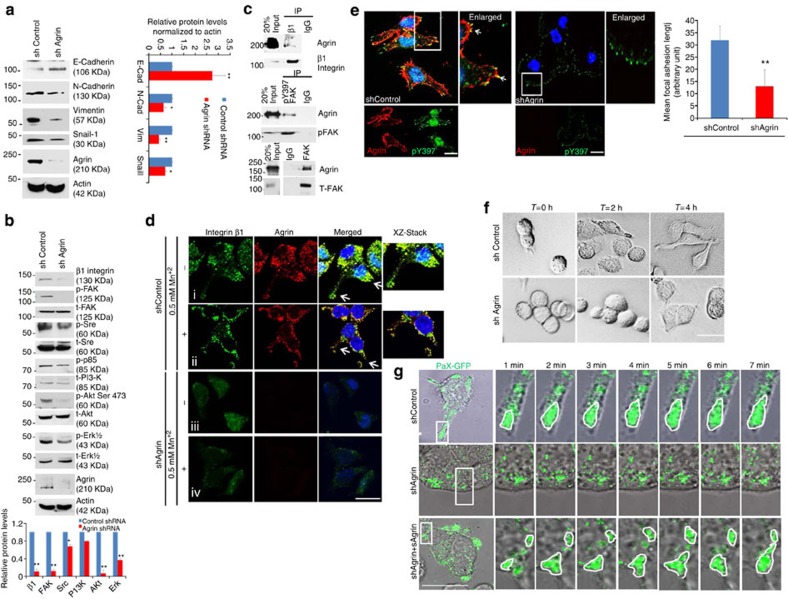
Agrin as an ECM sensor for EMT and FA integrity.(a,b) Total lysates of control or Agrin shRNA MHCC-LM3-transduced cells were analysed by western blots using antibodies against the indicated proteins. Quantification of proteins normalized to actin (a) or respective total protein levels (b) are depicted graphically. Error bars represent s.d. (*P value<0.04, **P value<0.002, Student’s t-test). (c) MHCC-LM3 cell lysates were IP with either rabbit IgG or anti-integrin β1 (upper panel), anti-FAK pY397 (middle panel) or anti-total FAK (T-FAK) antibody (lower panel) and western blotted for Agrin. The blot was stripped and re-probed for integrin β1 (upper panel), pFAK (middle panel) or T-FAK (lower panel). Sixty micrograms (20%) of whole-cell lysate were used as input control. (d) Control or Agrin-depleted cells were either mock or pre-treated with 0.5 mM MnCl2 solution in complete media for 30 min at 37 °C to activate FAs, washed and processed for immunofluorescence using rabbit integrin β1 and mouse Agrin antibodies. Representative images co-stained with TO-PRO3 are shown. White arrows indicate the enlarged area of cells where Z section was performed. Scale bar, 10 μm. (e) Control or Agrin-depleted MHCC-LM3 cells were immunostained using mouse anti-Agrin and rabbit anti-FAK (pY397) antibodies. Representative confocal images co-stained with TO-PRO3 are shown. Arrows indicate colocalization and boxed areas are represented as enlarged panels. FA length was analysed by ImageJ software and at least 10 different fields were chosen for analysis and data represents mean±s.d. (**P value=0.005, Student’s t-test). Scale bar: 10 μm. (f) Control or Agrin-depleted MHCC-LM3 cells plated on fibronectin (10 μg ml−1)-coated dishes. Morphological changes analysed by time-lapse differential interference contrast microscopy live-cell imaging at indicated time points. Scale bar, 10 μm. (g) Paxillin-GFP expressing control, Agrin-depleted MHCC-LM3 cells alone or supplemented with 10 μg ml−1 sAgrin for 1 day were plated on fibronectin-coated dishes. Three hours post plating, cells were imaged live for 7 min at an interval for 1 min. Representative time-lapse series of boxed region is enlarged and shown. Scale bar, 10 μm.